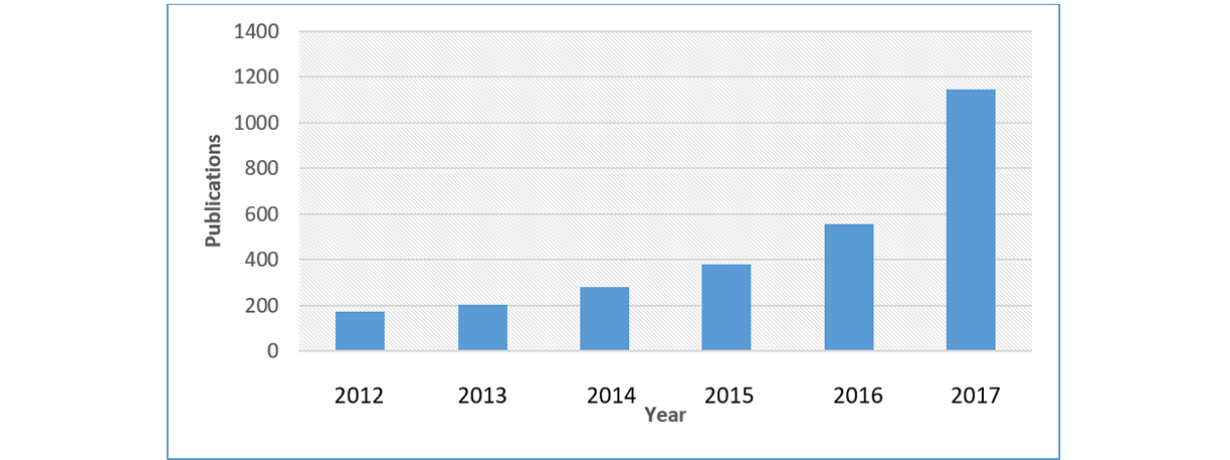
Figure 4. Trends of published papers that implement deep learning techniques. The data are generated by searching for “deep learning” on PubMed